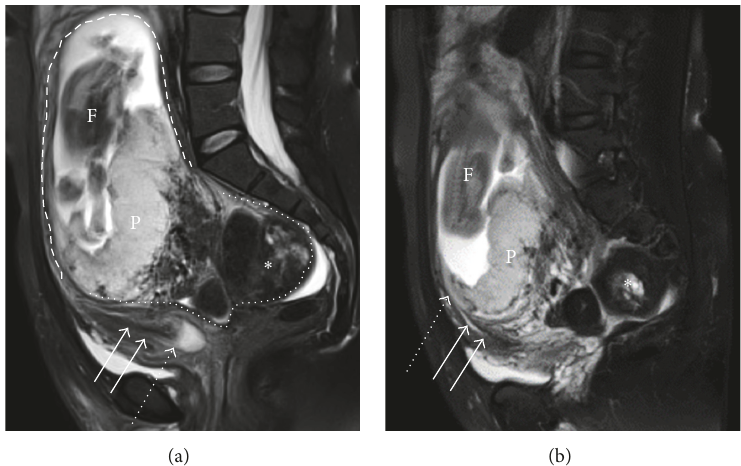
Figure 1: Sagittal T2-weighted magnetic resonance imaging (MRI) at 18 weeks of gestation shows a large fibroid (white asterisk) engaged in the pouch of Douglas. The cervix (white arrow) and the anterior wall of uterus (dashed line) are cranioventrally stretched. The fundus and the posterior wall of uterus (dotted line) were entrapped in the pelvis between the sacral promontory and pubic symphysis. Dashed arrows show external ostium of uterus (a) and internal one (b). F = fetus; P = placenta (a, b).